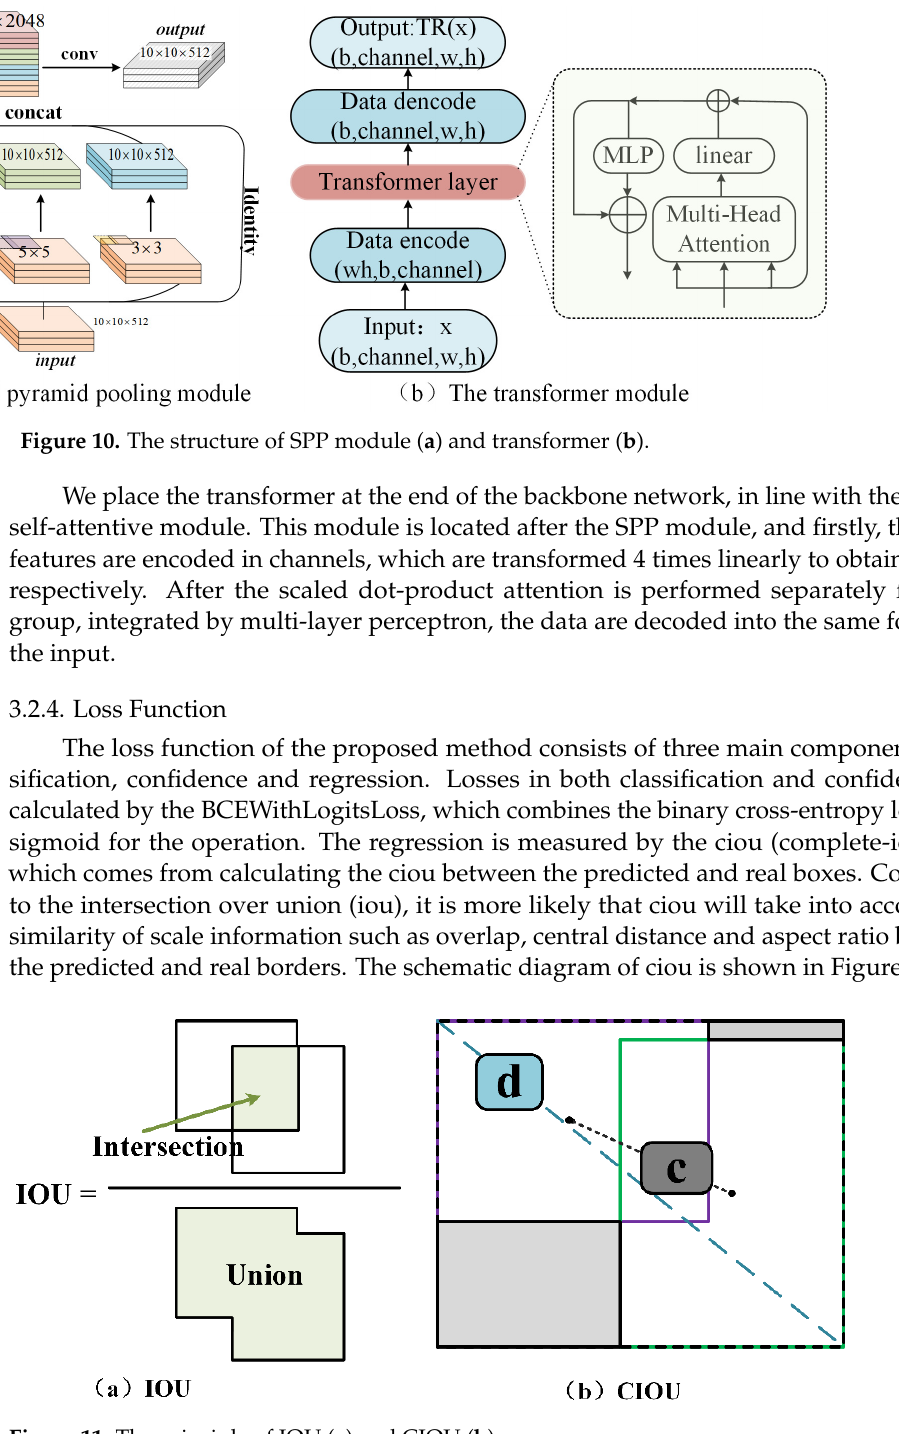
Figure 11. The principle of IOU ( a ) and CIOU ( b ).